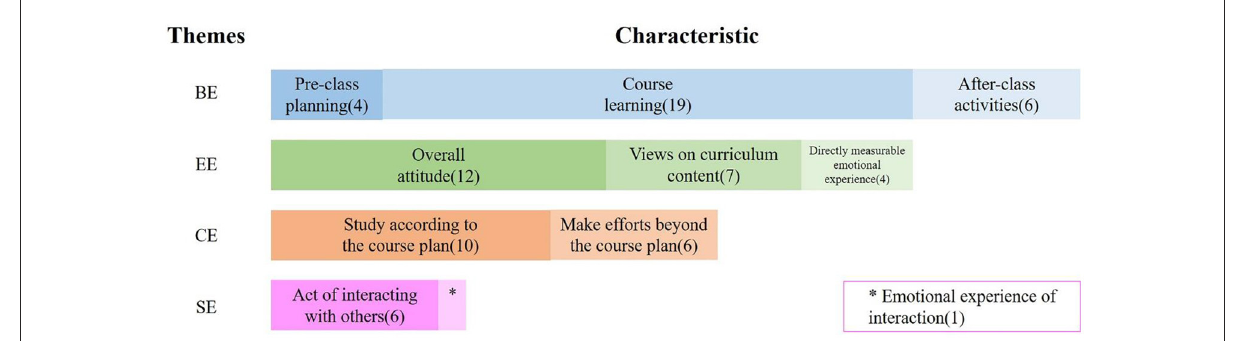
FIGURE3 Numbers of items used to measure aspects of learning engagement in massive open online courses.